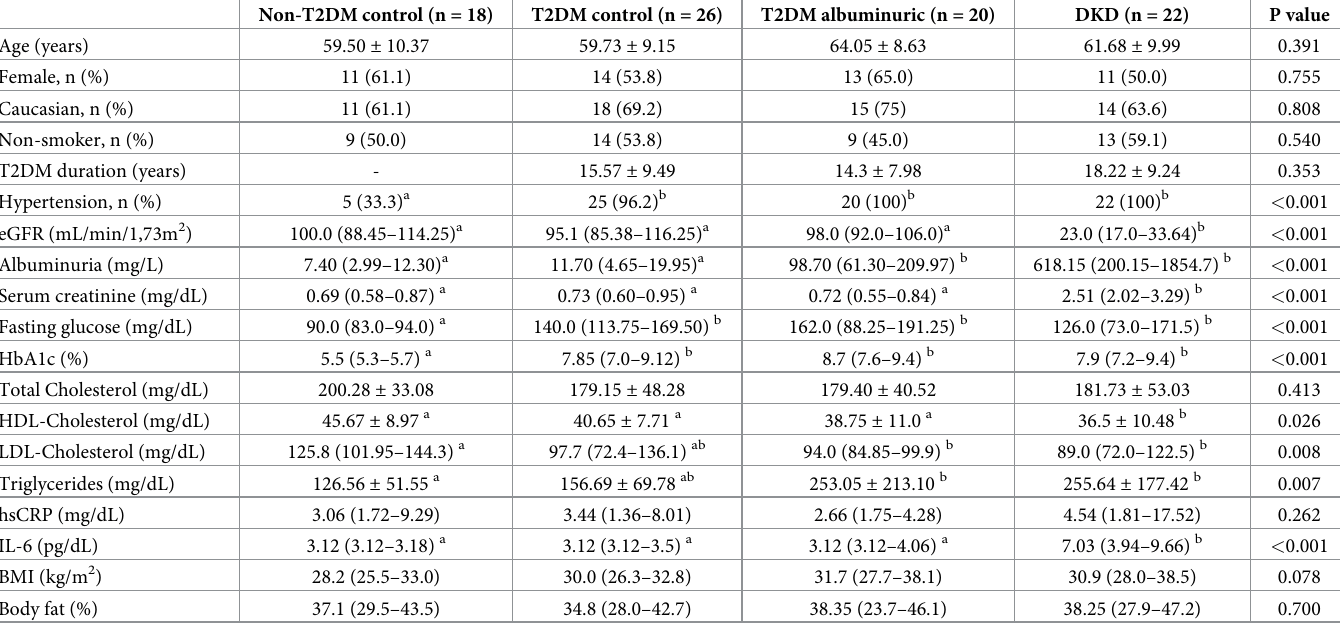
Table 1. Sociodemographic, clinical, biochemical and anthropometric characteristics among